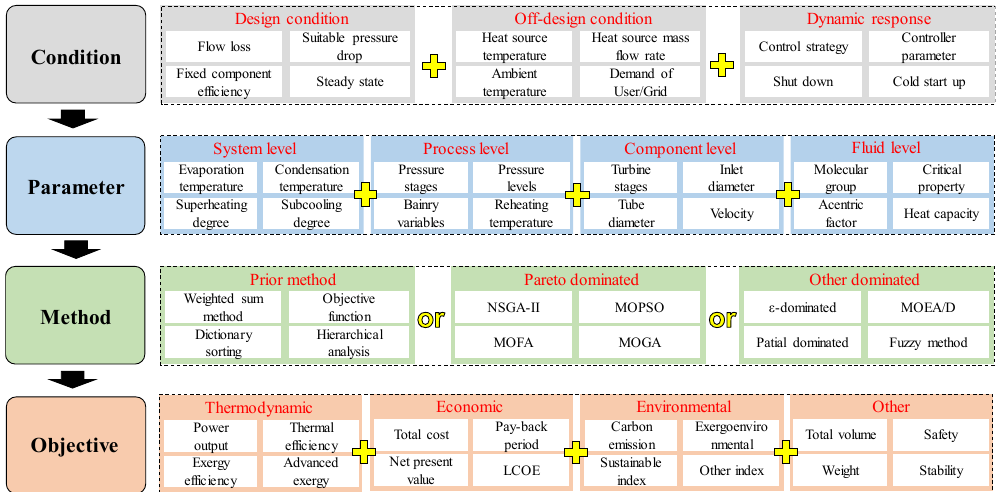
Figure 14. The multi-level optimization approach considering “system-process-component-fluid”.